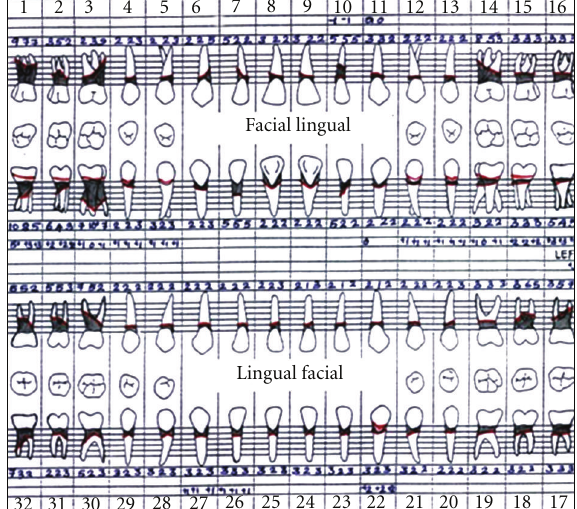
Figure 6: Periodontal charting showing generalized deep pockets and clinical attachment loss.